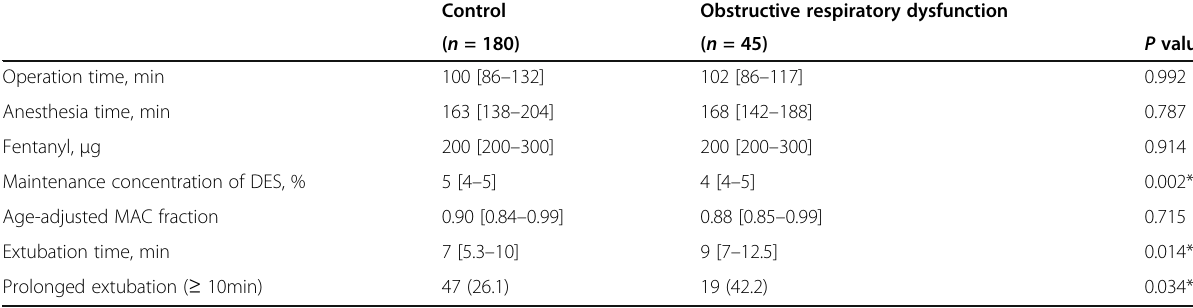
Table 3 Intraoperative demographics